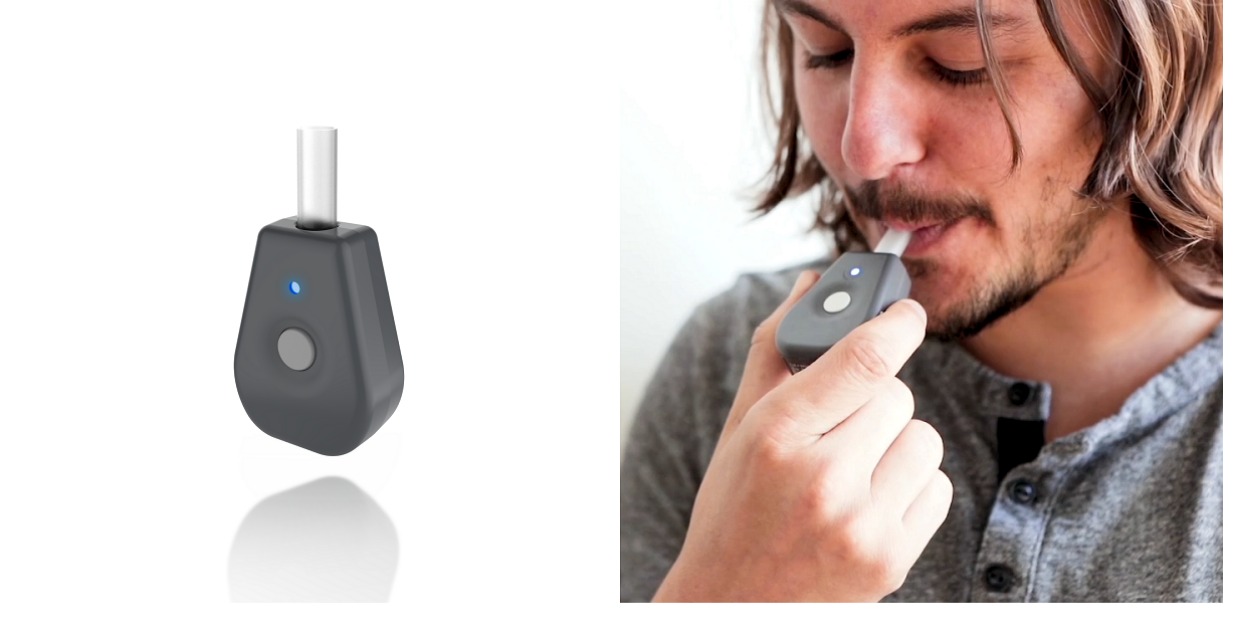
Figure 1. Pivot carbon monoxide breath